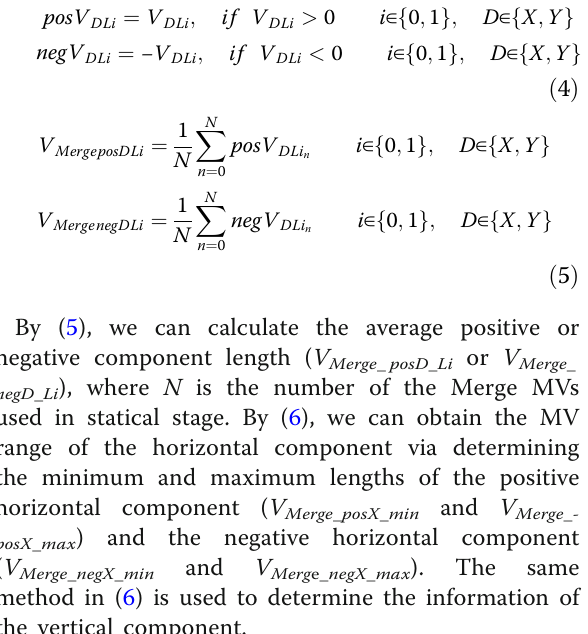
Table 1 Probability distribution for different search ranges [23] Training sequence